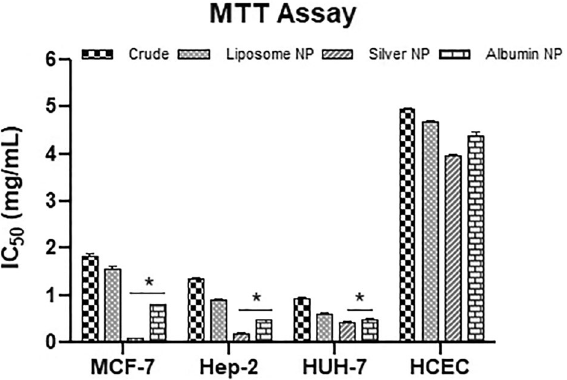
Figure 5. IC 50 of F. cretica plant extract and their NPs against MCF-7, Hep-2 and HUH-7 cell lines. Data denoted *(p < 0.05) are significant compared to control.